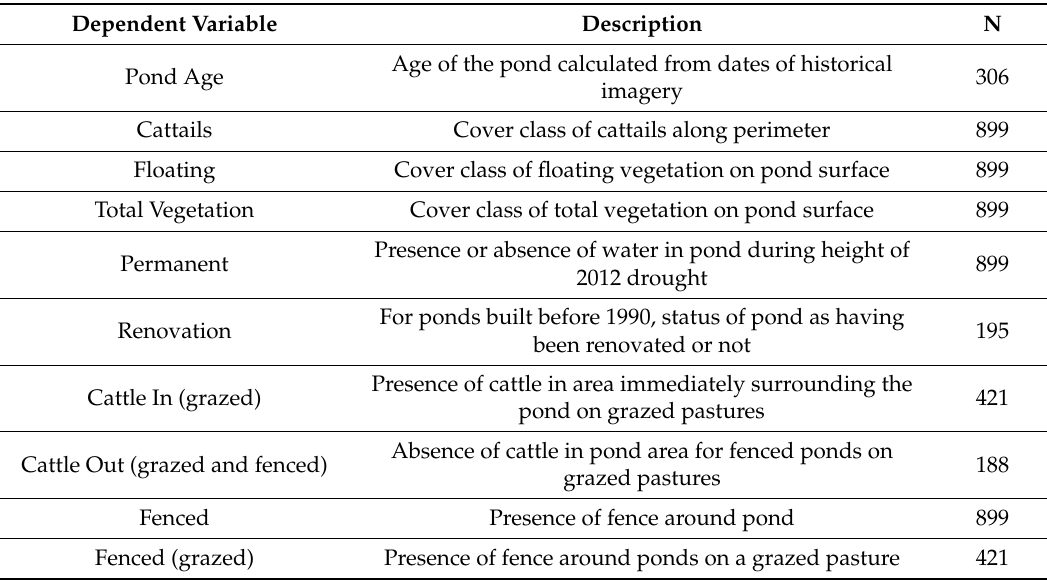
Table 1. Key analysis questions and response variables (with sample size of ponds [N]) used in